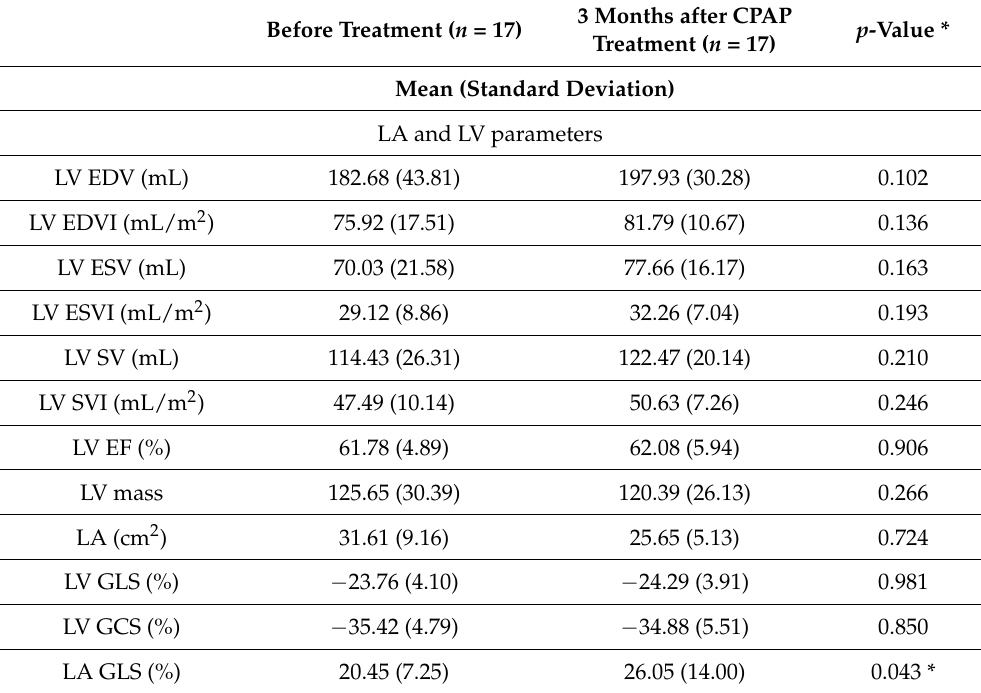
Table 5. Changes in cardiac MRI parameters in OSA group patients after treatment with